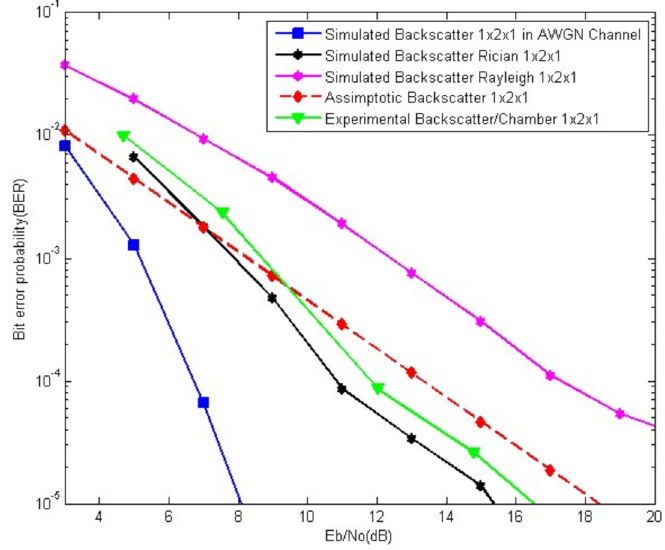
Figure 12. The BER results of a 1 × 2 × 1 system. Theoretical, simulated, and experimental results, K f = 4.5 and K b =